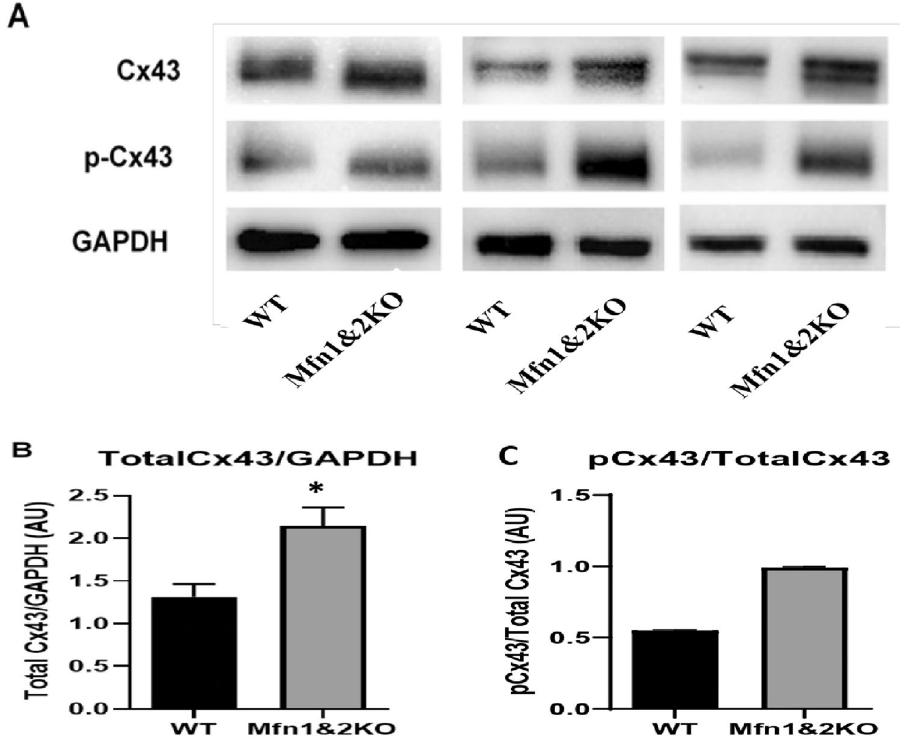
Figure 5. Cx43 protein expression in the Mfn-DKO versus WT hearts. ( A ) Representative immunoblots (cropped) of total Cx43 and phosphorylated Cx43 from 3 different WT versus Mfn-DKO hearts. Original gel images are presented in Supplementary Fig. 2. ( B ) Quantification of band intensity for total Cx43, normalized to GAPDH expression, *p < 0.05 when compared against WT. ( C ) Quantification of band intensity for phosphorylated Cx43, normalized to total